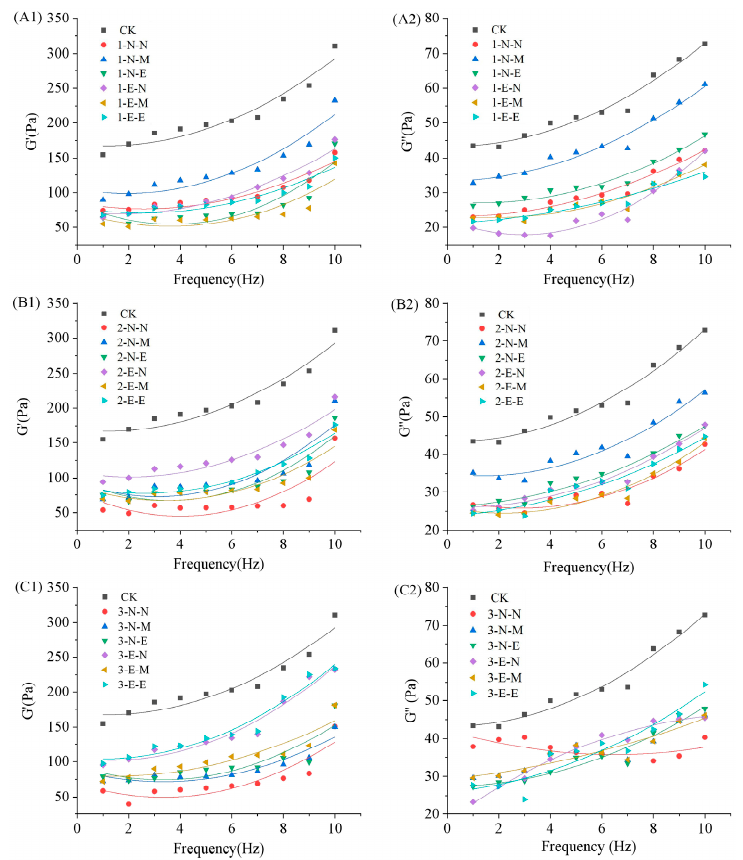
Figure 4. Rheological properties of freeze–thawed Mongolian cheese. ( A1 , B1 , C1 ) are G’ plots of frozen cheese at di ff erent temperatures ( − 10 °C, − 20 °C, − 30 °C), respectively. Correspondingly, frozen cheese at different temperatures ( − 10 ◦ C, − 20 ◦ C, − 30 ◦ C), respectively. Correspondingly, ( A2 , B2 , C2 ) are G’ plots. ( A2 , B2 , C2 ) are G’